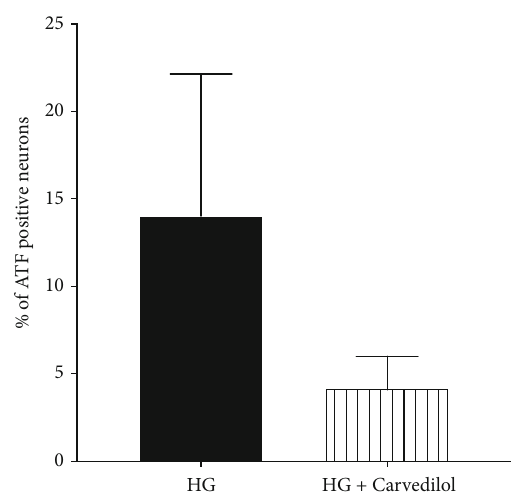
Figure 8: Percentage of ATF-positive neurons in high-glucose DRG